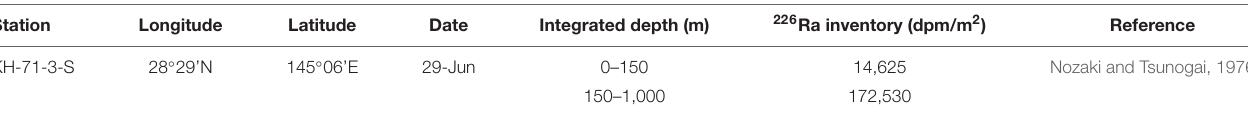
TABLE 2 | 226 Ra inventories integrated from 0 to 150 m and from 150 to 1,000 m in the w-NPO.